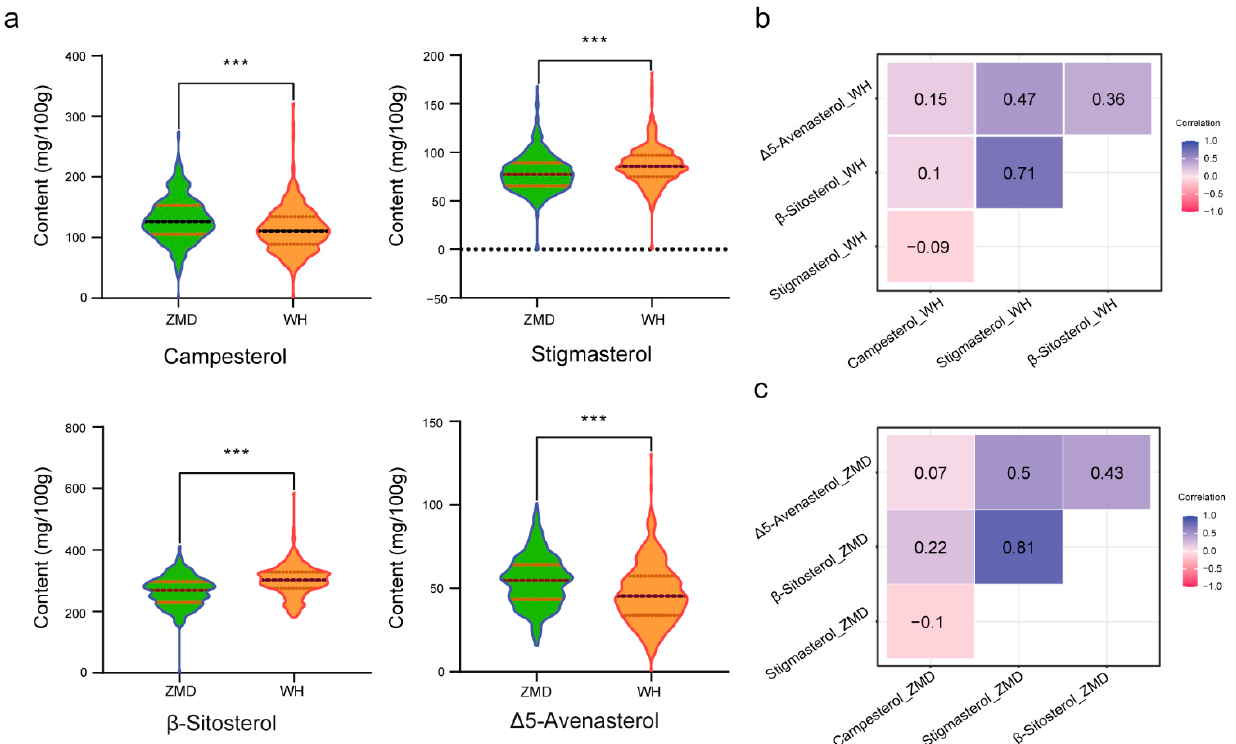
Figure 2. Variation and correlation of four phytosterol contents in sesame. Variation of four phytos- terol contents in two different environments ( a ). *** indicates significant difference at p < 0.001. The correlation between the four phytosterols in Wuhan, WH ( b ) and Zhumadian, ZMD ( c ).